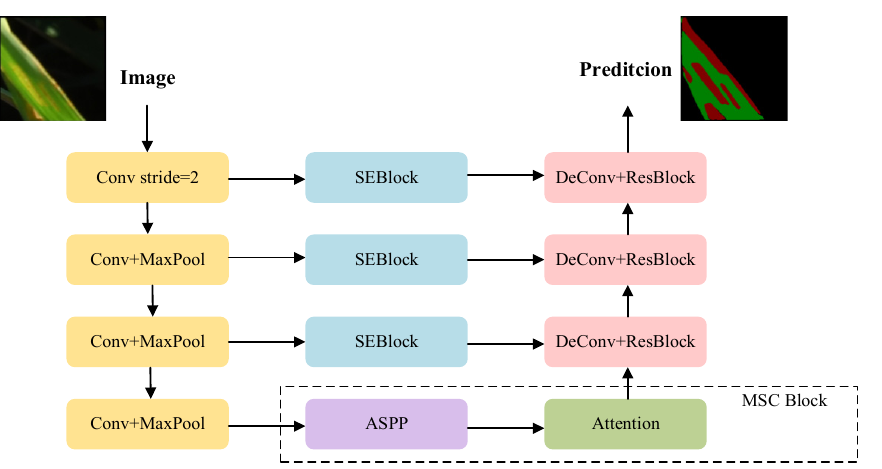
Figure 3. Overall architecture of BLSNet. Conv stride = 2 represents the down-sample block with convolution operation of kernel size of 3 and stride size of 2. Conv + MaxPool stands for the down-sample block composed of convolution operation of kernel size of 3, followed by a maximum pooling of kernel size of 2. DeConv + ResBlock stands for the up-sample block, i.e., DeConv is convolutional transposed operation of kernel size 3, ResBlock uses residual connection. The detailed implementation process is described in the following sections.